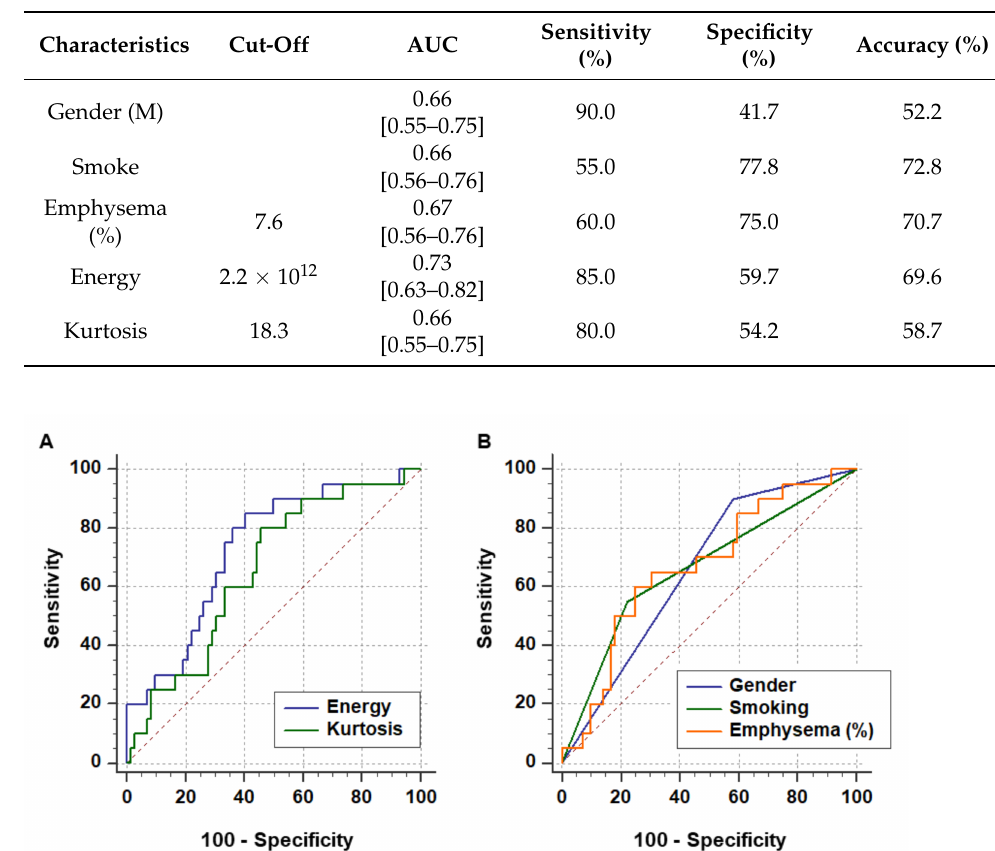
Figure 5. ROC curve for differentiating cancer-associated and non-cancer IPF. ( A ) Radiomics features (energy and kurtosis) demonstrated acceptable performance, with an AUC of 0.66–0.73, which was not inferior to ( B ) the performance of traditional risk factors (gender, smoke, and emphysema), with an AUC of